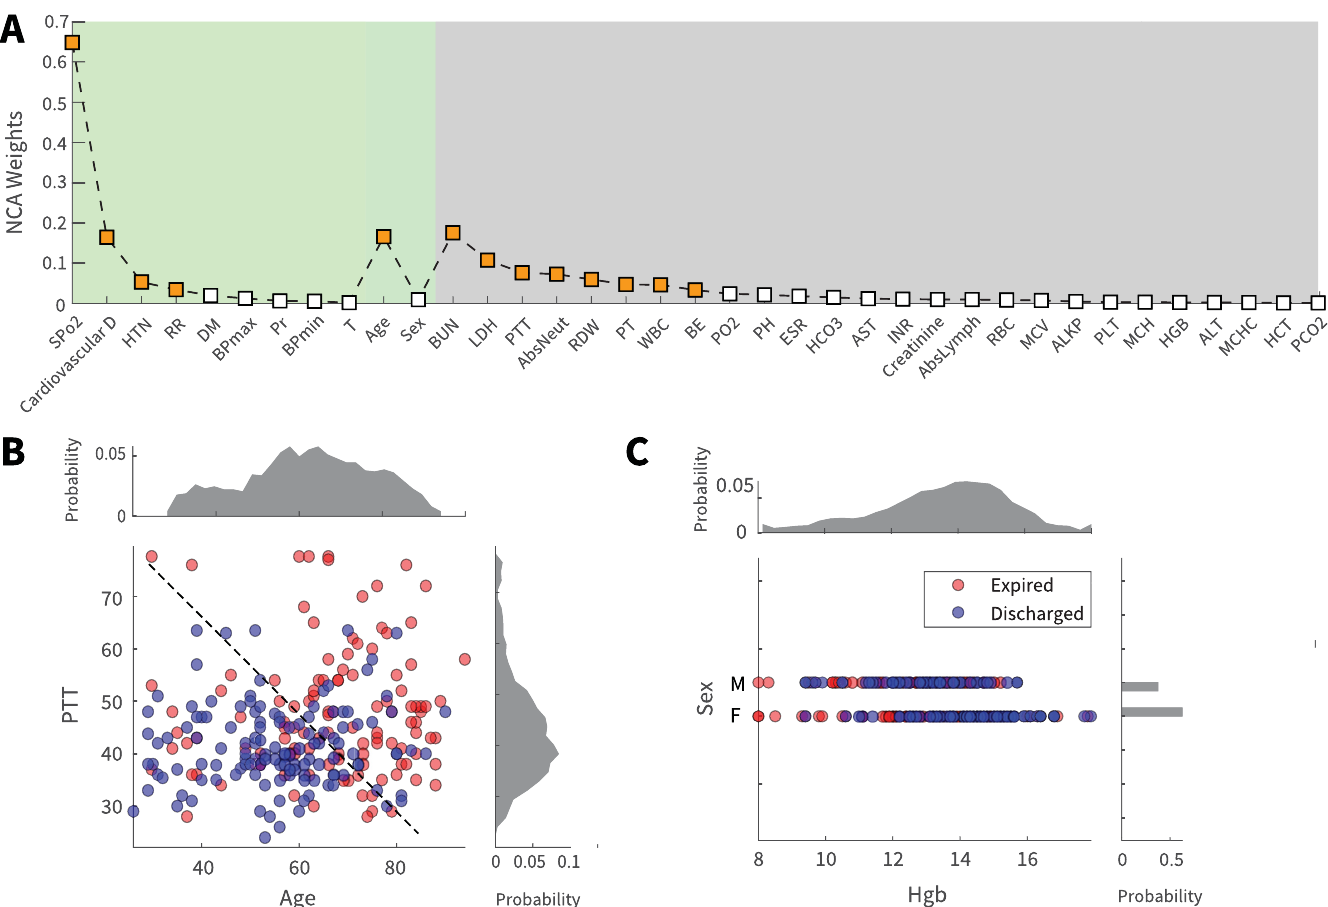
Fig 2. Contribution of demographic, clinical, and laboratory features to mortality prediction. ( A ) The results of the regularized NCA analysis displays the contribution of single features to mortality prediction. Features are sorted based on contribution importance and category. Features with prominent weights were displayed by orange squares for visual convenience. ( B ) is a favorable feature space (PTT and age) where the information content of features with respect to the outcome is high, so many data points could be visually distinguished via an illustrative decision border. Panel ( C ), in contrast, demonstrates unfavorable feature space where the low information content of features has led to data points becoming crunched and hard to distinguish (Sex and Hgb). Panels B and C were created using half of the data and Principal Component Analysis (PCA) for illustrative purposes.